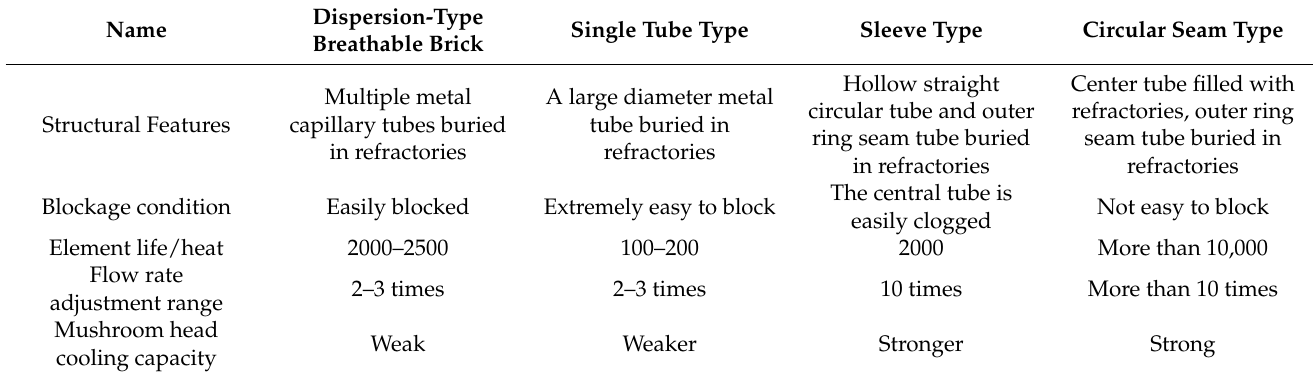
Table 5. Comparison of the structural characteristics and performance of bottom blowing elements.